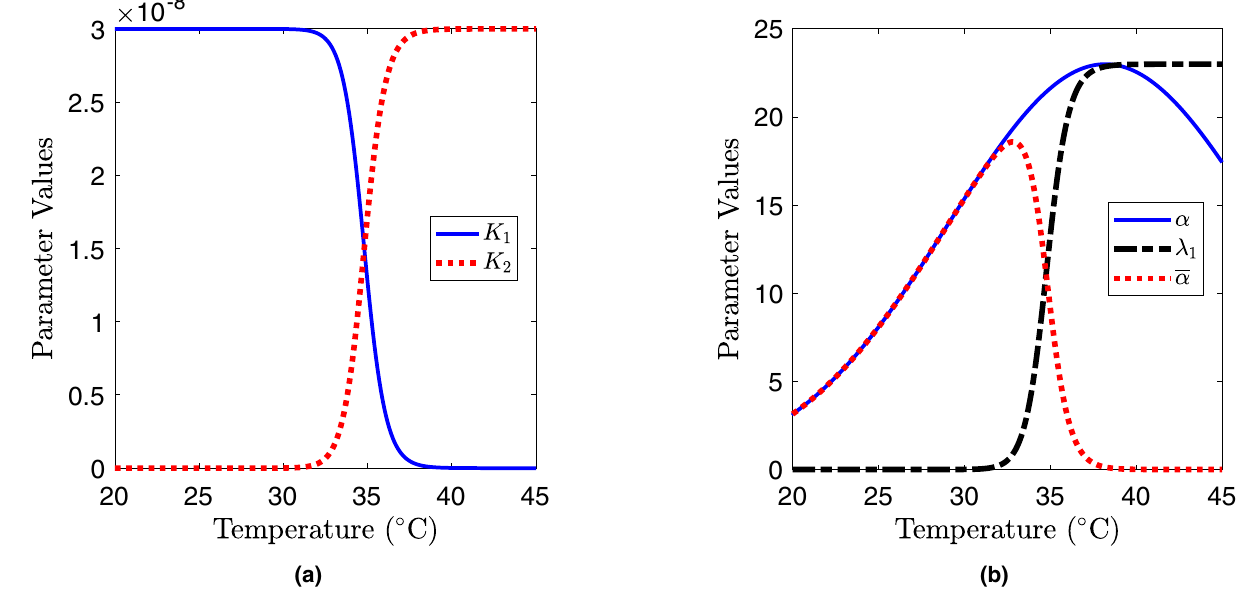
Figure 2. ( a ) Temperature dependence of the adsorption constants K i ( i = 1, 2 ) of the phage (measured in ml − 1 day − 1 ). ( b ) Growth rates of susceptible α( T ) and lysogenic α( T ) bacteria and the transition rate (cid:31) 1 ( T ) − 1 from the lysogenic cycle to the lytic cycle (measured in day ). The corresponding analytical expressions for the temperature dependence are given by